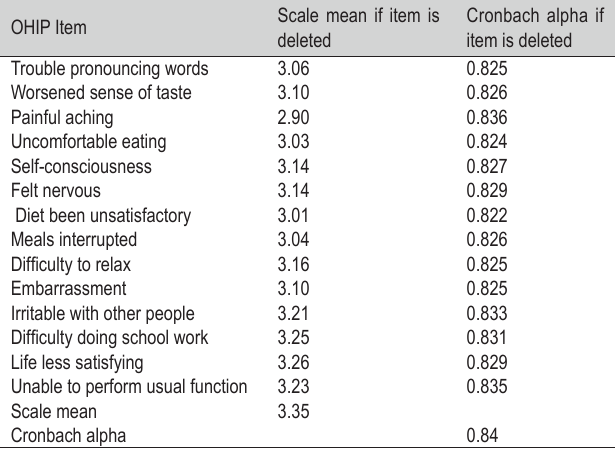
Scale mean if item is deleted